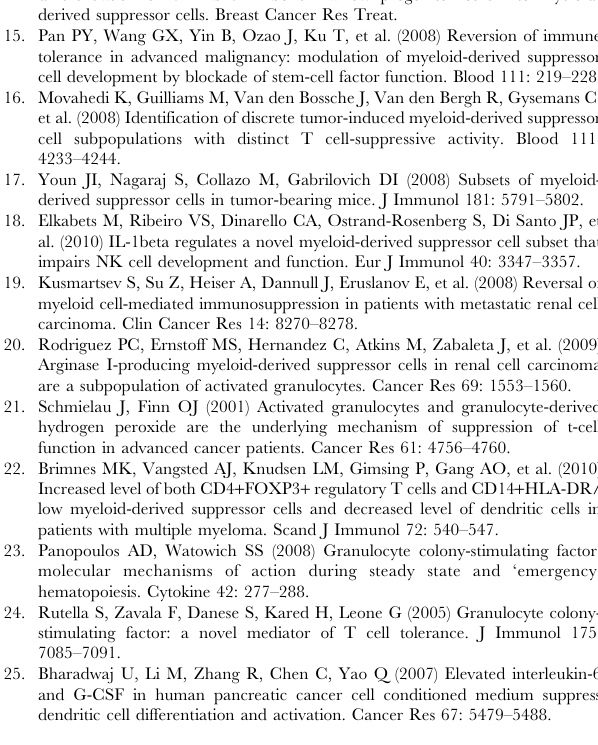
by flow cytometry for the percentages of granulocytic and monocytic subsets, based on differential staining with anti- Figure S5 G-CSF receptor expression on monocytic and granulocytic MDSC. G-CSF receptor expression was analyzed on splenic MDSC subsets from the indicated CMS4 tumor- bearing mice. Splenocytes were stained for CD11b and Gr-1 expression and then further gated based on differential Gr-1 levels (Gr-1 high or Gr-1 low ) to phenotypically distinguish granulocytic from monocytic MDSC subsets, respectively. The gated cells were then analyzed for G-CSF receptor expression relative to isotype control staining.